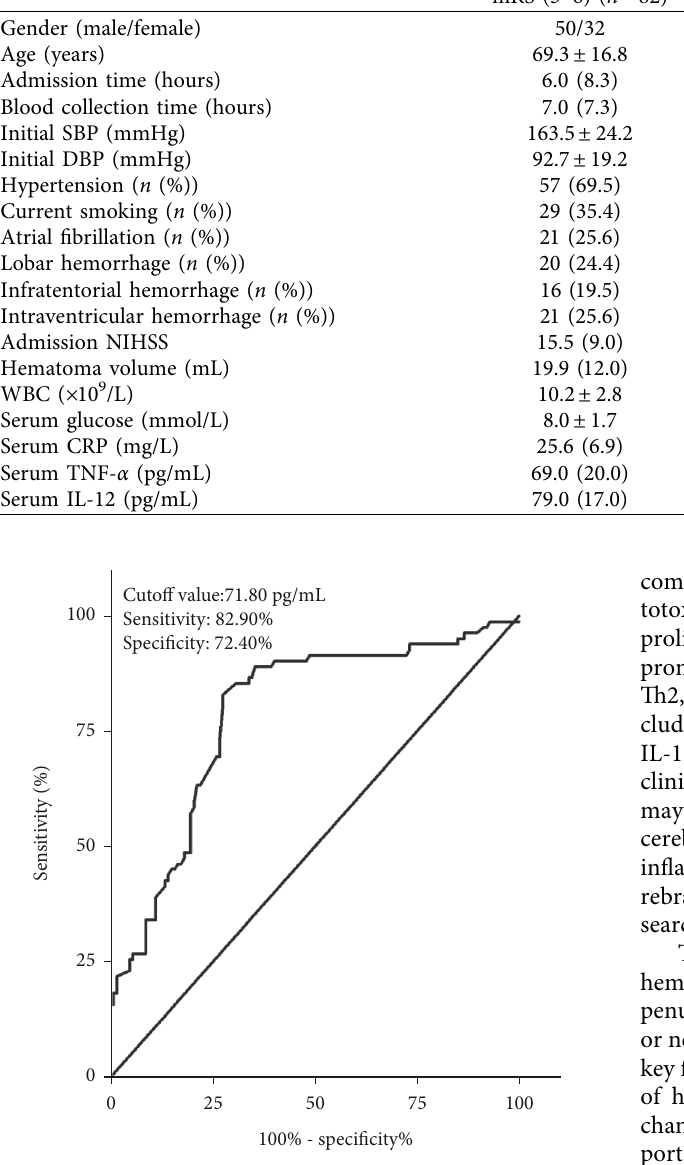
Figure 7: ROC curve analysis regarding predictive value of serum IL-12 levels for 3-month poor outcome after intracerebral